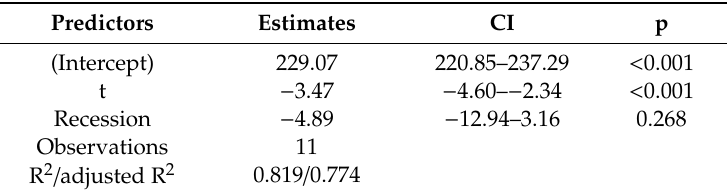
Table 6. Model 2 results for Government